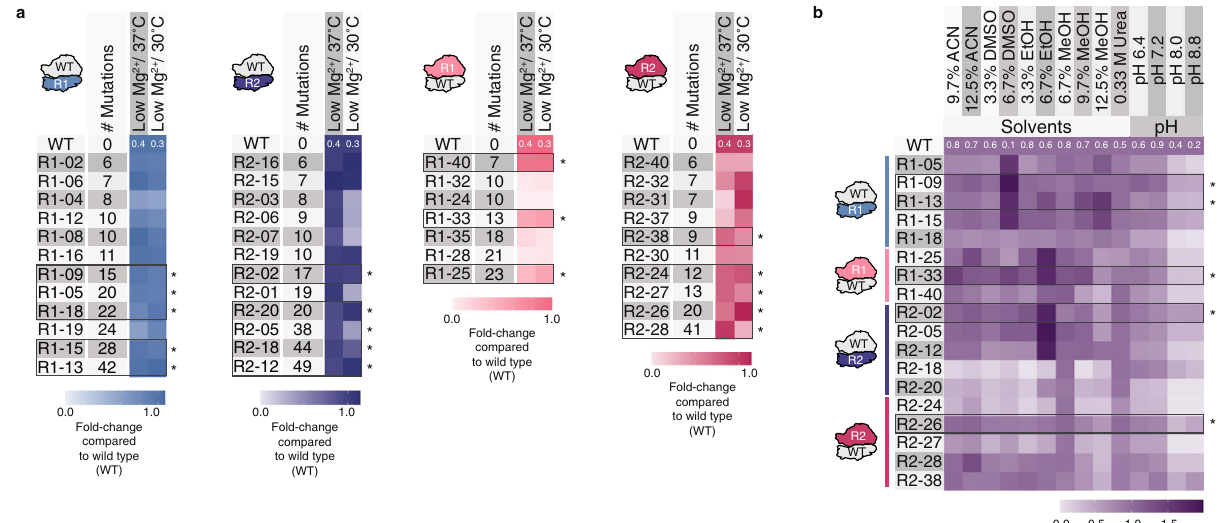
Fig.3|EternarRNAdesignsarerobustacrossdiversestressconditionsinvitro. Designs with ≥ 6 mutations and activity of ≥ 80% wild type (WT) at optimal